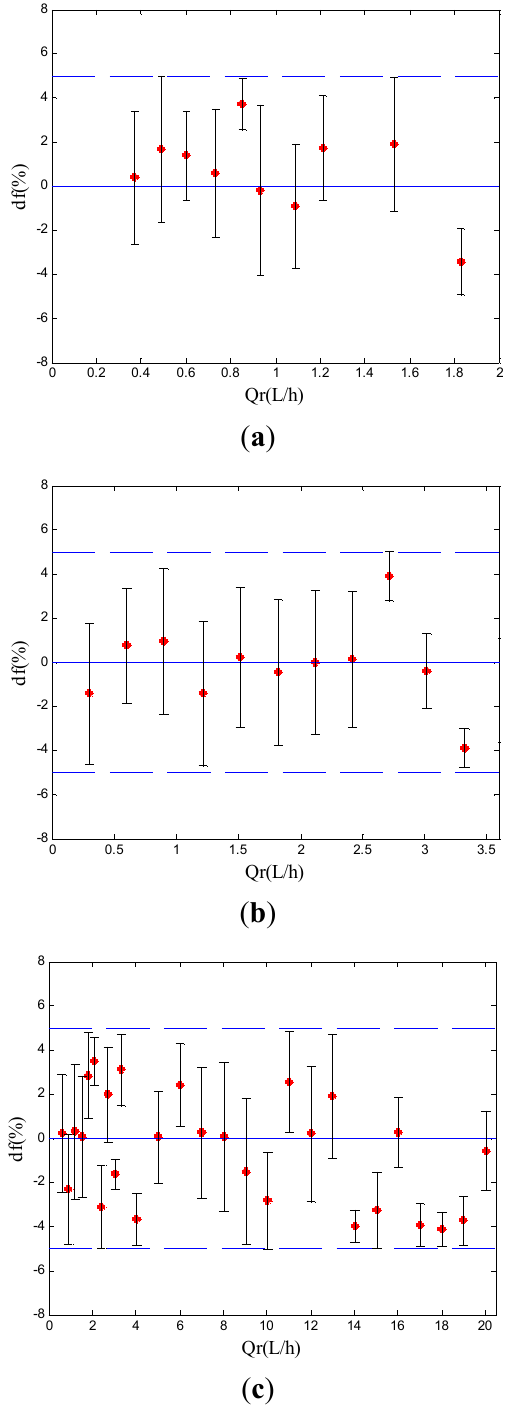
Figure 8. The experimental results in five millimeter-scale pipes. ( a ) Experimental results in 0.5 mm i.d. pipe. ( b ) Experimental results in 0.8 mm i.d. pipe. ( c ) Experimental